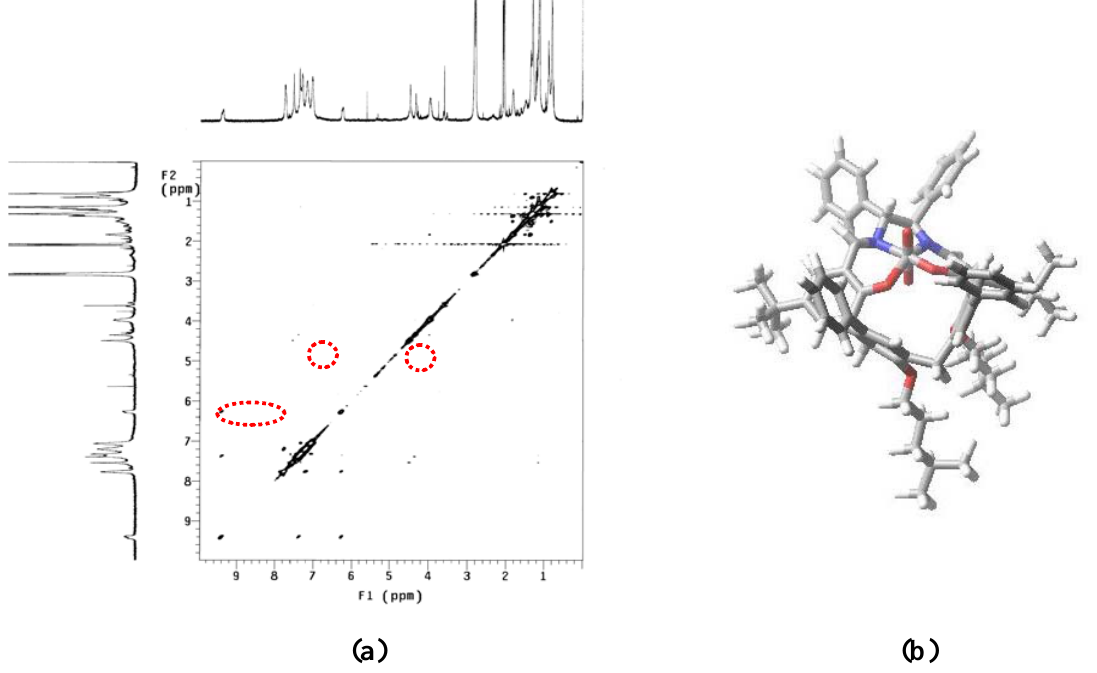
) CO, 300K) T-ROESY map and ( b ) modelled 3 2 2